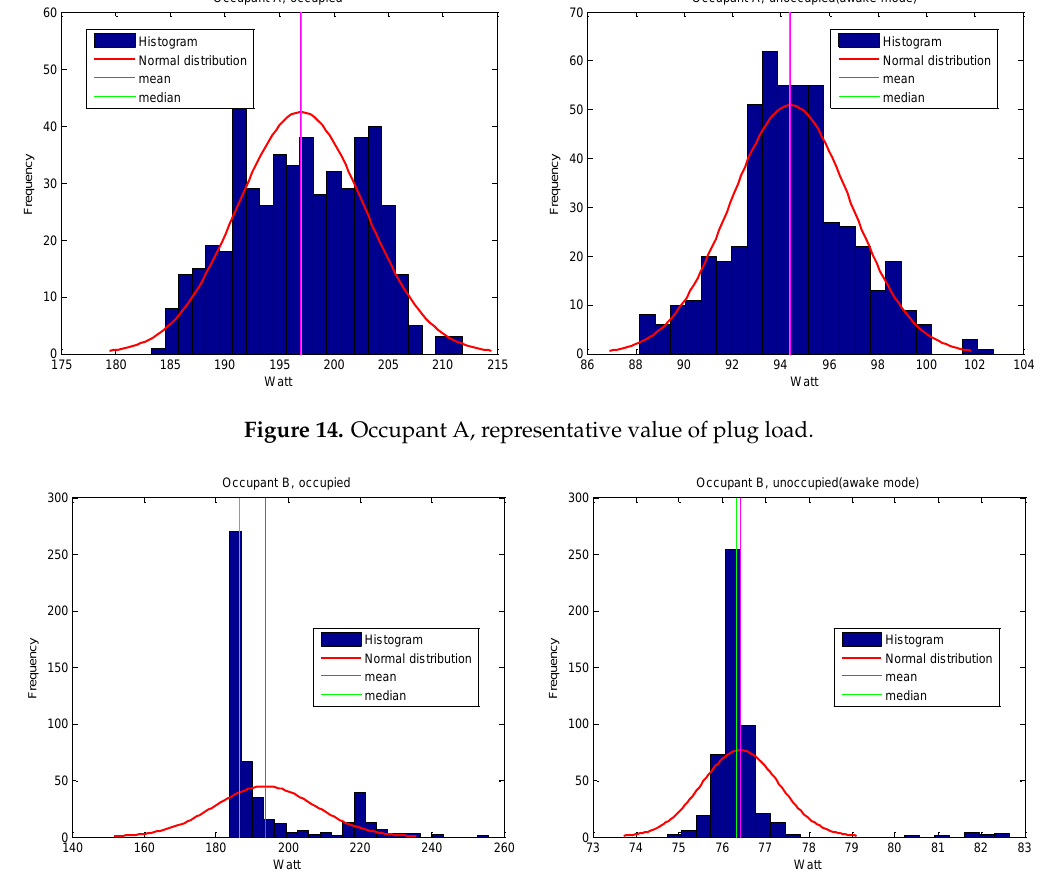
Figure 15. Occupant B, representative value of plug load.